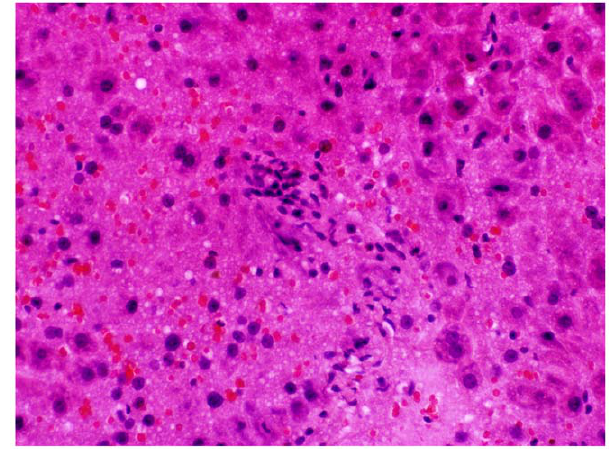
Figure 8. Liver injury group P. Hepatocytes showing displaced nucleus to the periphery, known as ballooning in an animal from group P.